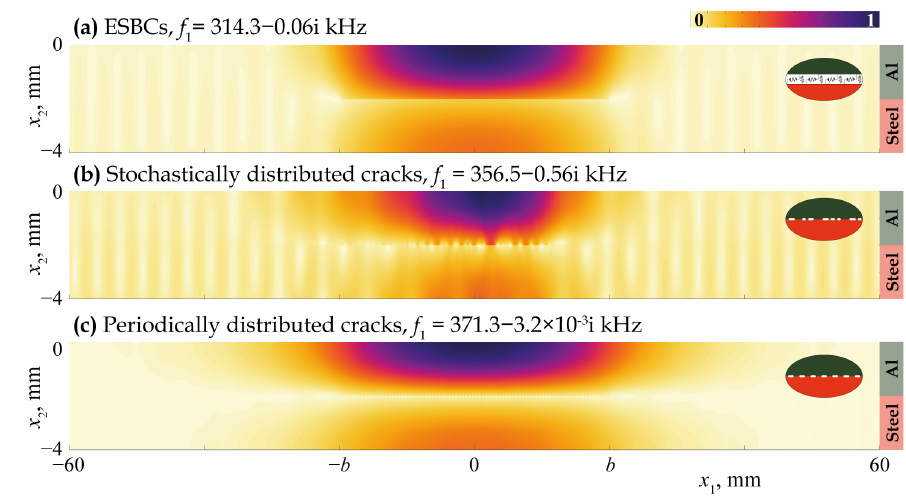
Figure 13. Eigenforms | u | ( x 1 , x 2 ) related to eigenfrequencies f 1 for a uniform partially closed delami- nation of length w = 40 mm with the crack density C = 0.8 modelled as an array of stochastically ( b ) and periodically ( c ) distributed cracks and via the ESBCs ( a ).